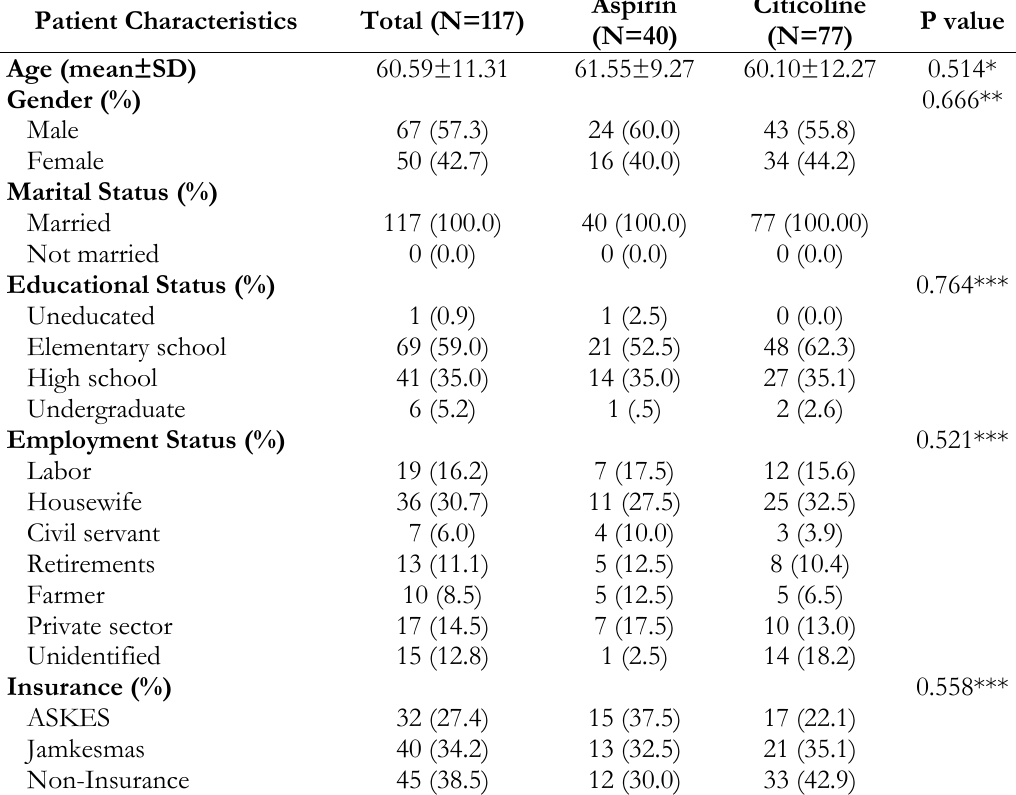
Table I: Socio-demographics and other characteristics of the study subjects Patient